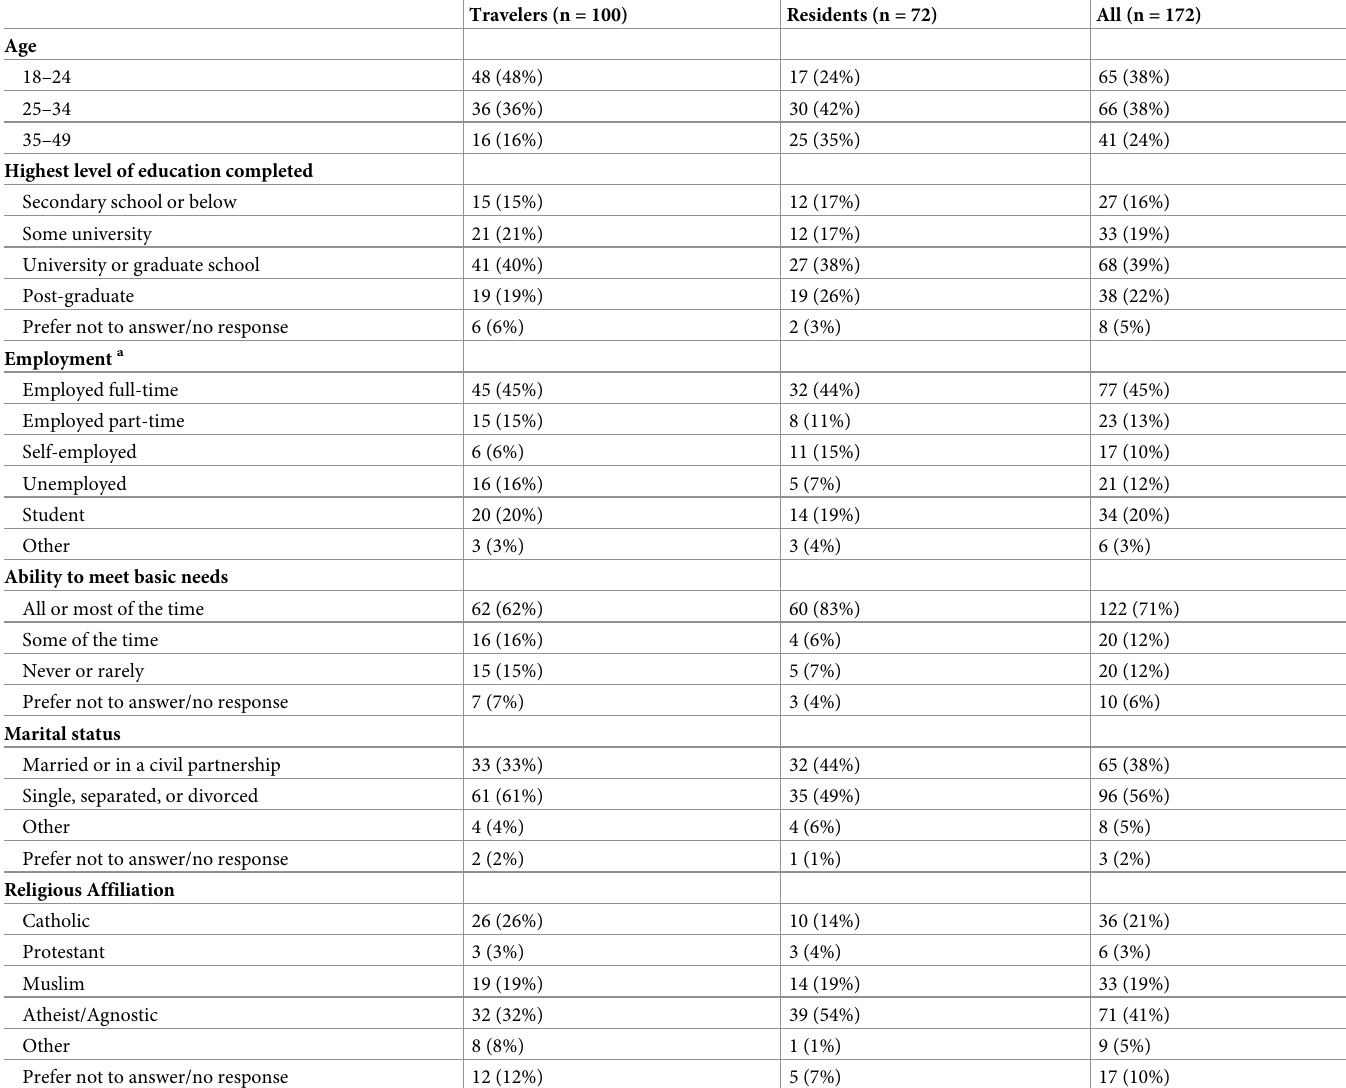
Table 2. Socio-demographic